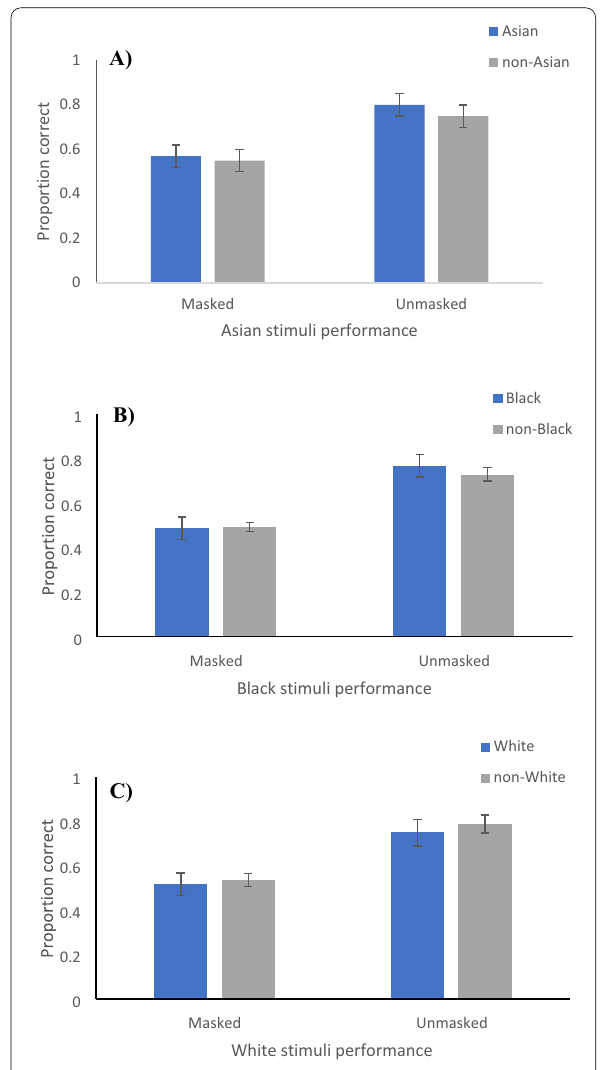
Fig. 3 Bar graphs showing the proportion correct for masked and unmasked Asian, Black, and White stimuli: A Asian faces, split by Asian vs non-Asian observers. B Black faces, split by Black vs non-Black observers. C White faces, split by White vs non-White observers. Error bars represent 95% confidence